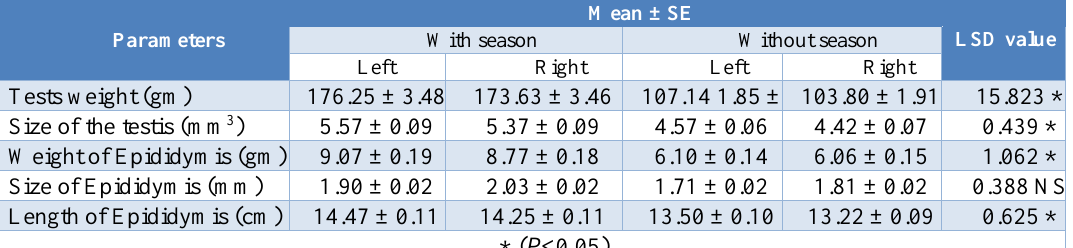
Table, 2: Effect of testicular orientation on testicular and epididymal parameters under season